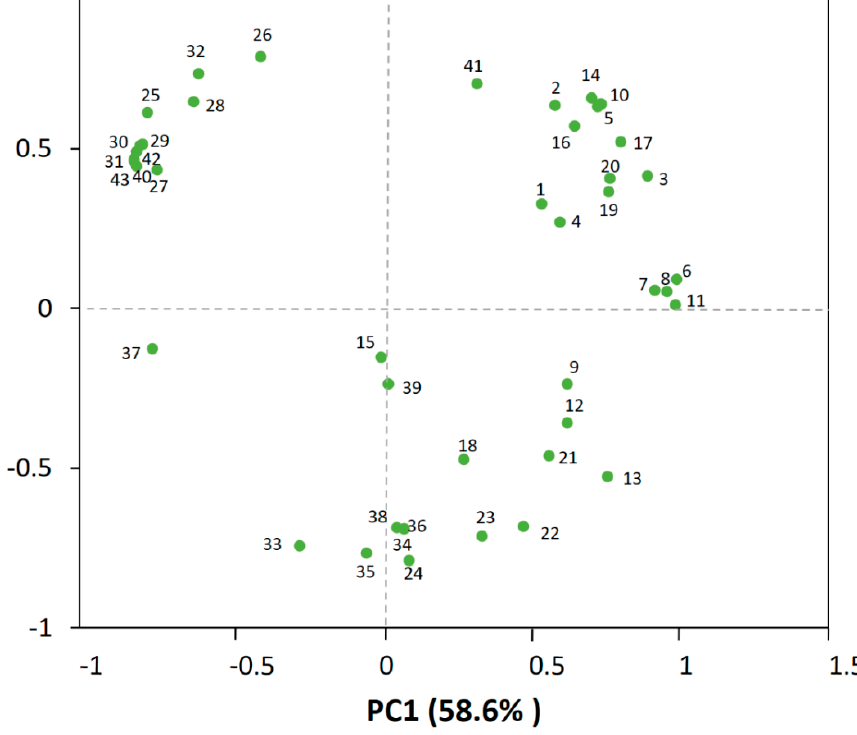
Figure 2. Principal component analysis (PCA) of the 51 aroma-active compounds in the jujube wine. Numbers close to each dot correspond to the code number in Table 1. The PCA plot showed that the majority of esters, such as ethyl caprylate (10), ethyl decanoate (14), ethyl hexanoate (5), phenethyl acetate (17), ethyl benzoate (16), ethyl butyrate (2), and ethyl 3-phenylpropionate (20), had been separated distinctly, which